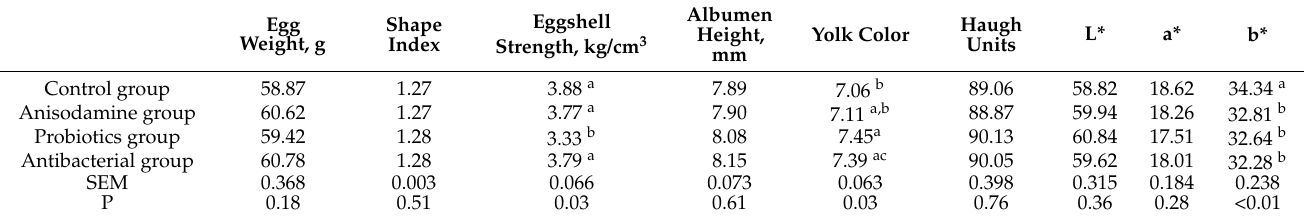
Table 3. Effects of different additives on egg quality of high DM